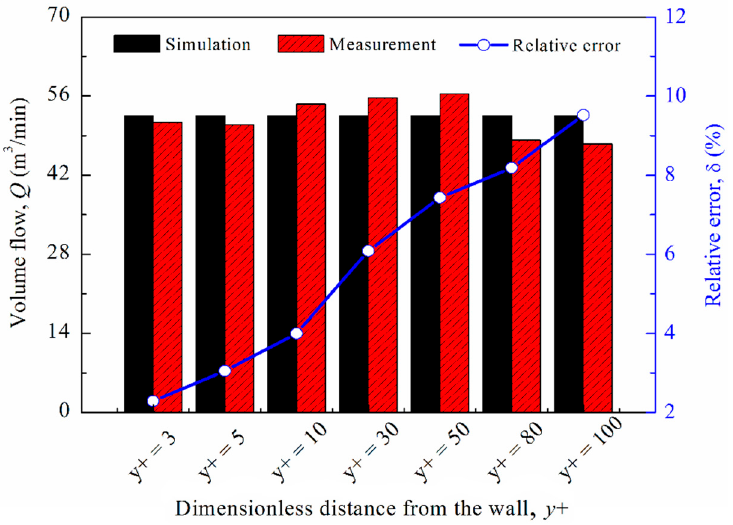
Figure 4. Influence of y + on the volume flow.